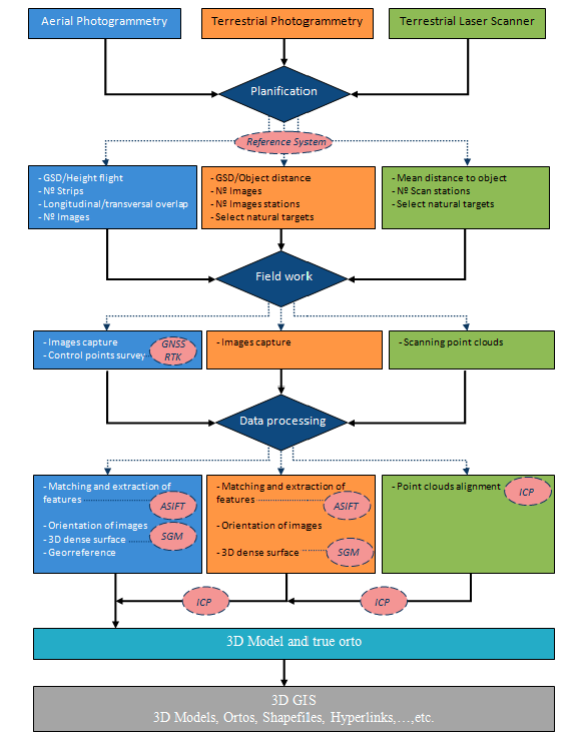
Figure 2. Multi-sensor and multi-data source workflow for the 3D reconstruction of complex archaeological